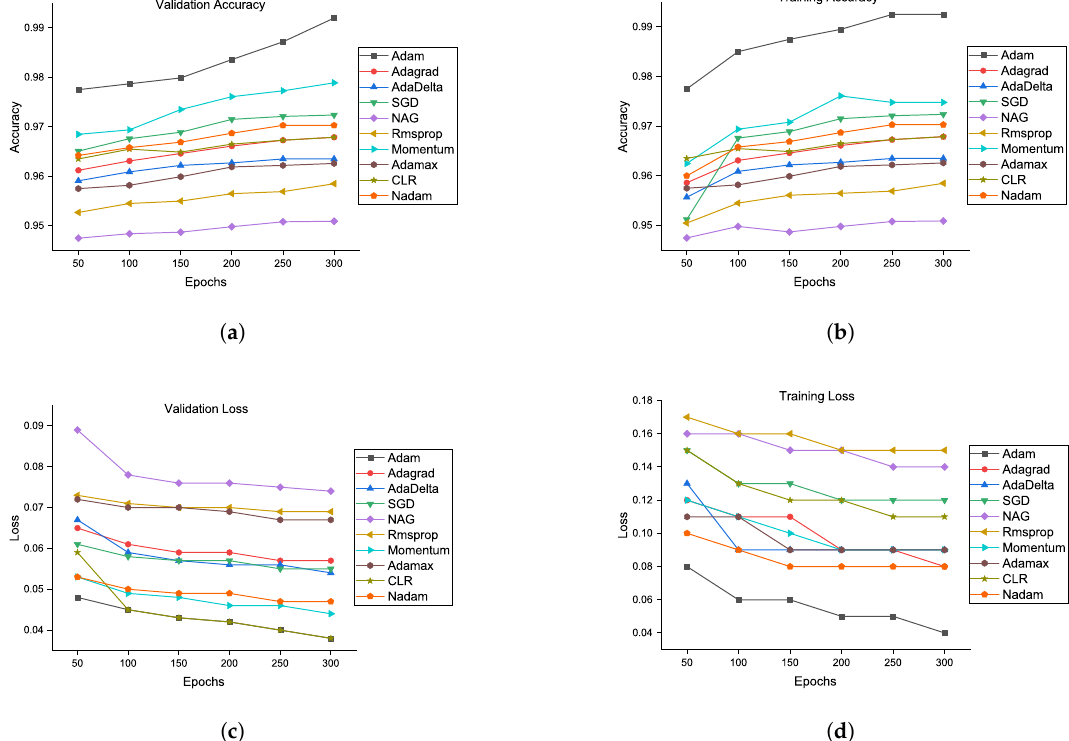
Figure 5. Validation accuracy and loss comparison of all optimizers using our proposed architecture: ( a ) validation accuracy, ( b ) training accuracy, ( c ) validation loss, and ( d ) training